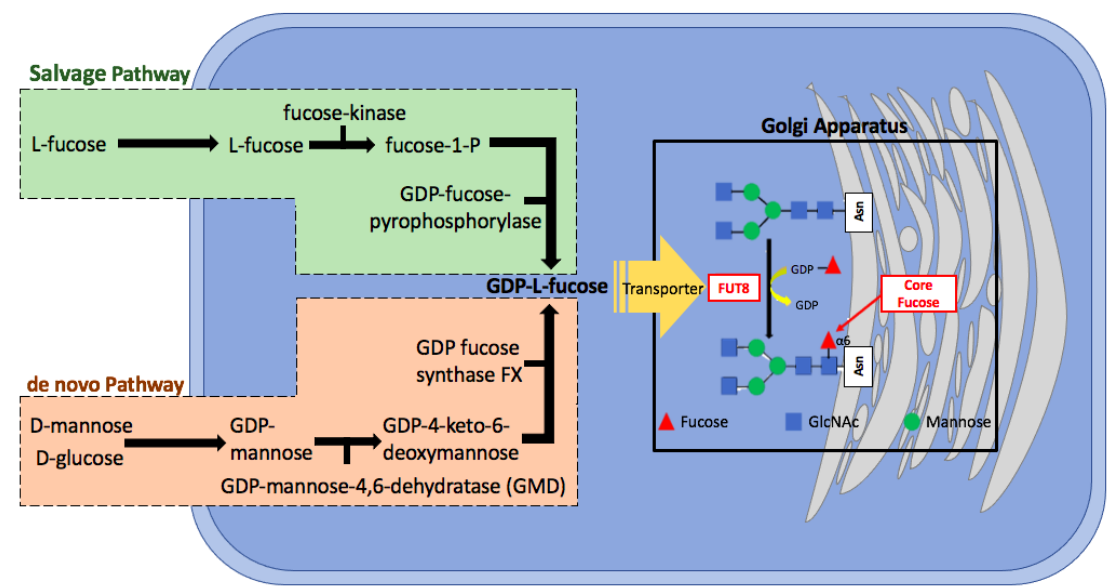
Figure 2. The sythetic pathway for GDP-fucose. GDP-fucose, an essential component of core fucosyaltion is produced by two different pathways within the cell. The predominat de novo pathway relies on GMD and FX proteins. Adapted from [32].